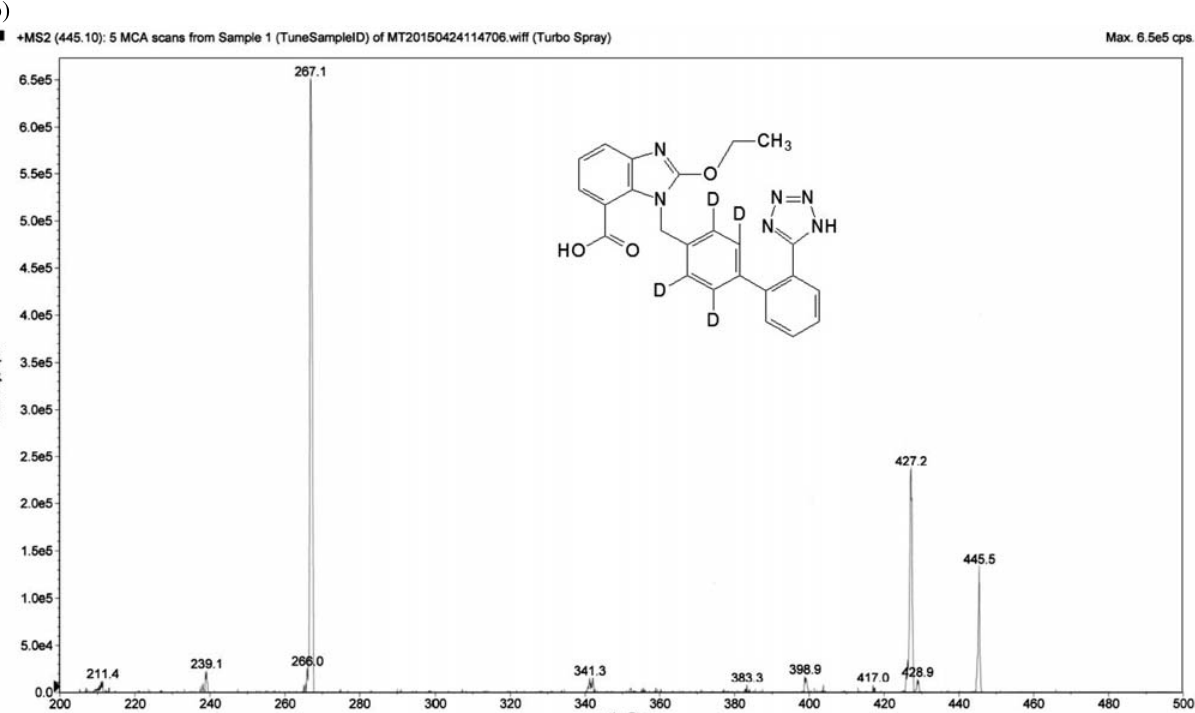
Figure 1: Product mass spectra (MS/MS) and chemical structure of (A) candesartan and (B) candesartan-d